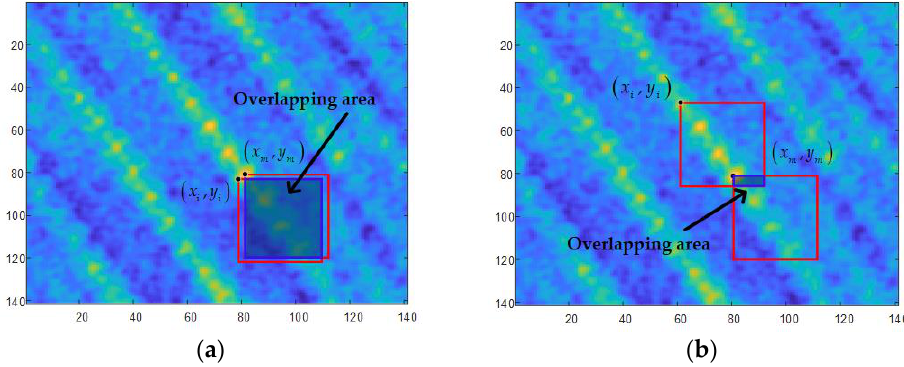
Figure 8. Schematic diagram of non-maximum suppression. ( a ) Non-extreme point that needs to be suppressed; ( b ) extreme point that needs to be preserved.